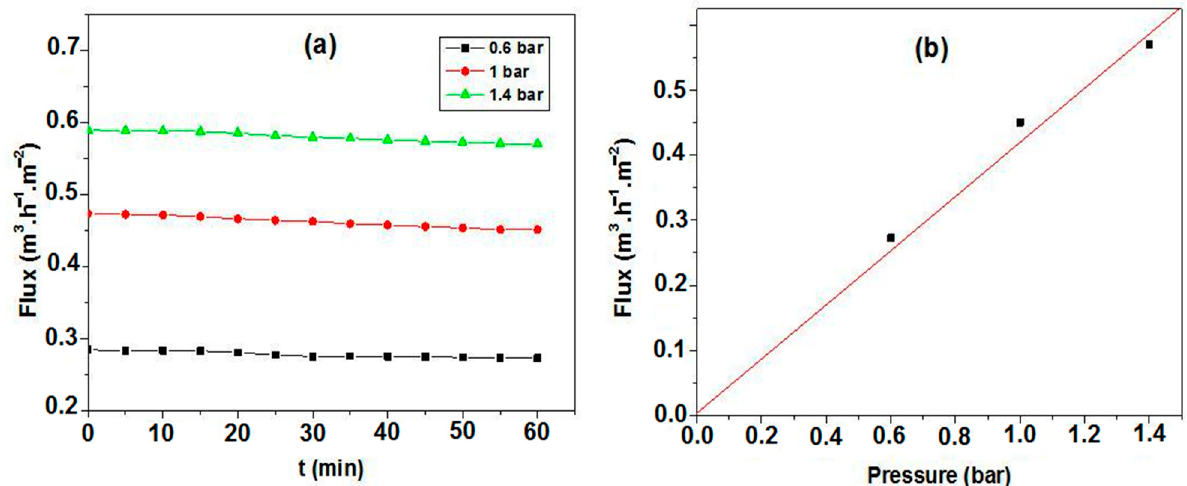
Figure 14. ( a ) Distilled water flux versus time, at different working pressures, ( b ) Water flux variation as a function of the different applied pressures for the membrane.